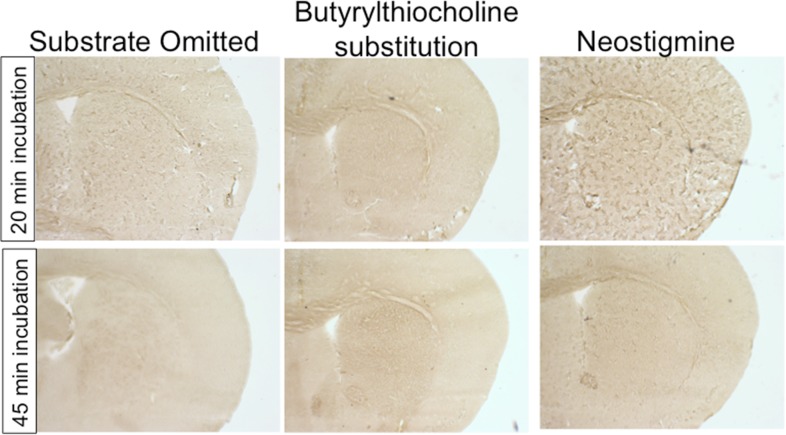
AChE histochemistry is selective for AChE.Assay controls demonstrate that omitting substrate, substituting an alternate thiocholine substrate, or inhibiting AChE activity with neostigmine fully abolishes staining.